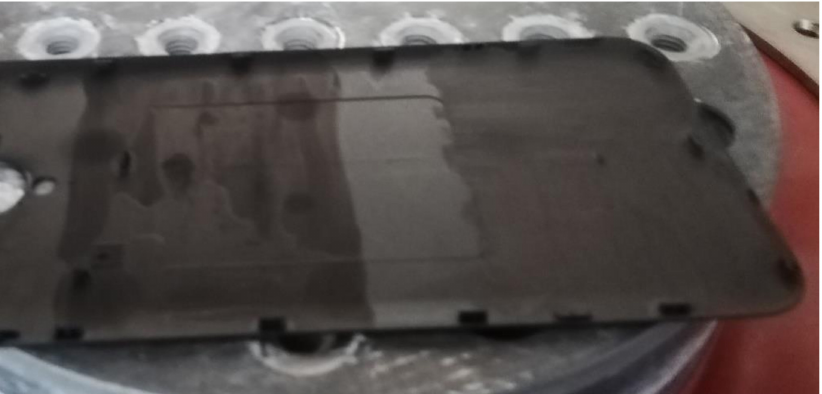
Figure 13. The sample coatings after two combined cycles of temperatures from +60 ◦ C to − 20 ◦ C and relative humidity from RH 90% to 10% with 8 h maintaining time at higher and lower temperatures.